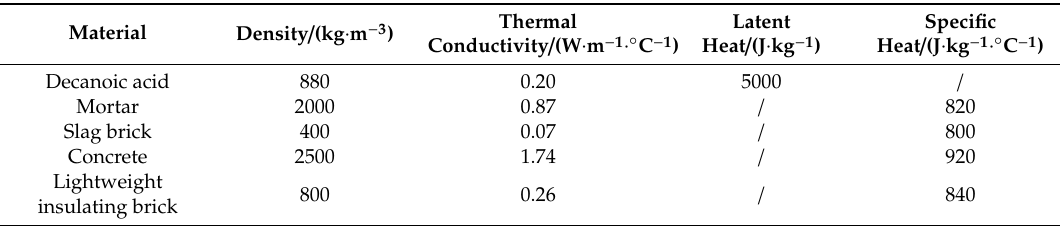
Table 1. Thermal parameters of phase change